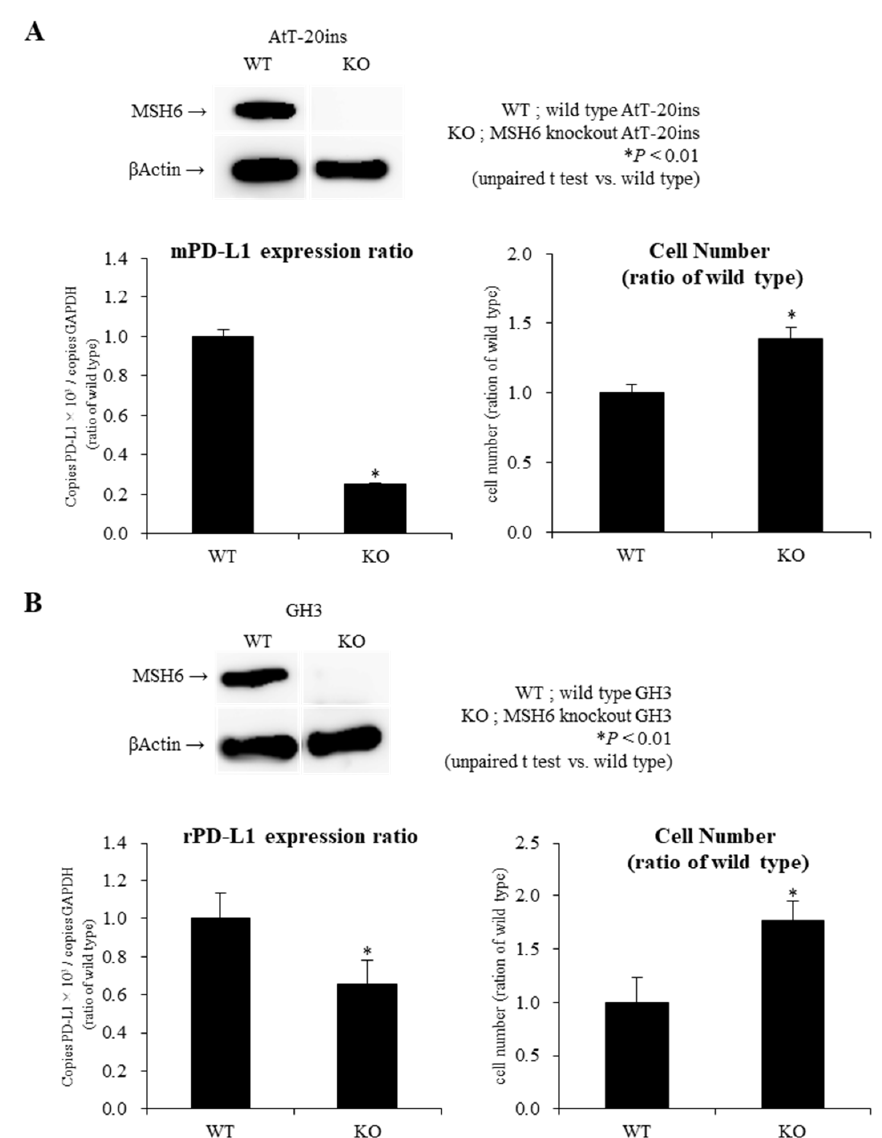
Figure 3. Knockout of MSH6 expression by Cells by Clustered Regularly Interspaced Short Palindromic Repeats / Cas9 (CRISPR-Cas9) system reduces PD-L1 mRNA expression with promotion of cell proliferation in AtT-20ins ( A ) and GH3 ( B ) cells. We generated MSH6-knockout AtT-20ins and GH3 cells using the CRISPR-Cas9 system. MSH6 was knocked out in AtT-20ins and GH3 by Western blotting. The knockout of MSH6 significantly reduced PD-L1 mRNA expression with promotion of cell proliferation in AtT-20ins and GH3 cells by qRT-PCR and Cell Counting Kit-8 analysis. * p < 0.01.